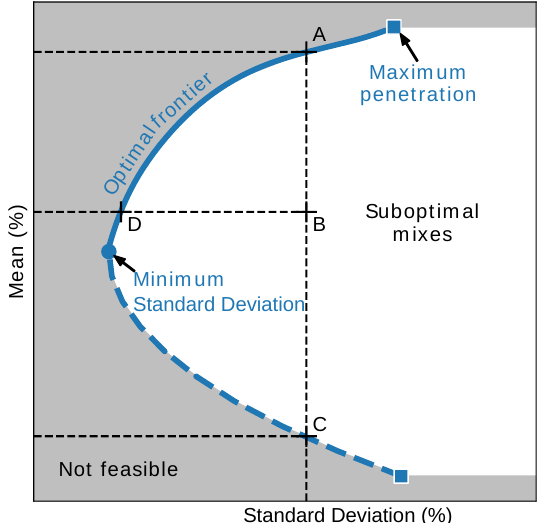
Figure 2. Example of the optimal frontier of a mean-variance biobjective optimization problem. The optimal frontier is one-dimensional and represented by a plain blue line. Mixes in the white region to the right of the frontier are suboptimal. Points in the gray region to the left of the frontier are not feasible. In this example, the optimal frontier is bounded below by a minimum-variance optimal mix (blue dot) below which the variance may only increase. The optimal frontier is bounded above by a maximum-penetration optimal mix above which higher penetration mixes are not feasible due to the constraints of the problem. The point B is an example of suboptimal mix, since a higher mean penetration is achievable for the same variance (point A) and a lower variance is achievable for the same mean penetration (point D). The dashed blue line is obtained by minimizing the variance for a range of target mean penetration values. These solutions are, however, not Pareto optimal. For instance, point C yields the same variance as point A but achieves a lower mean penetration. Thus, A “dominates”